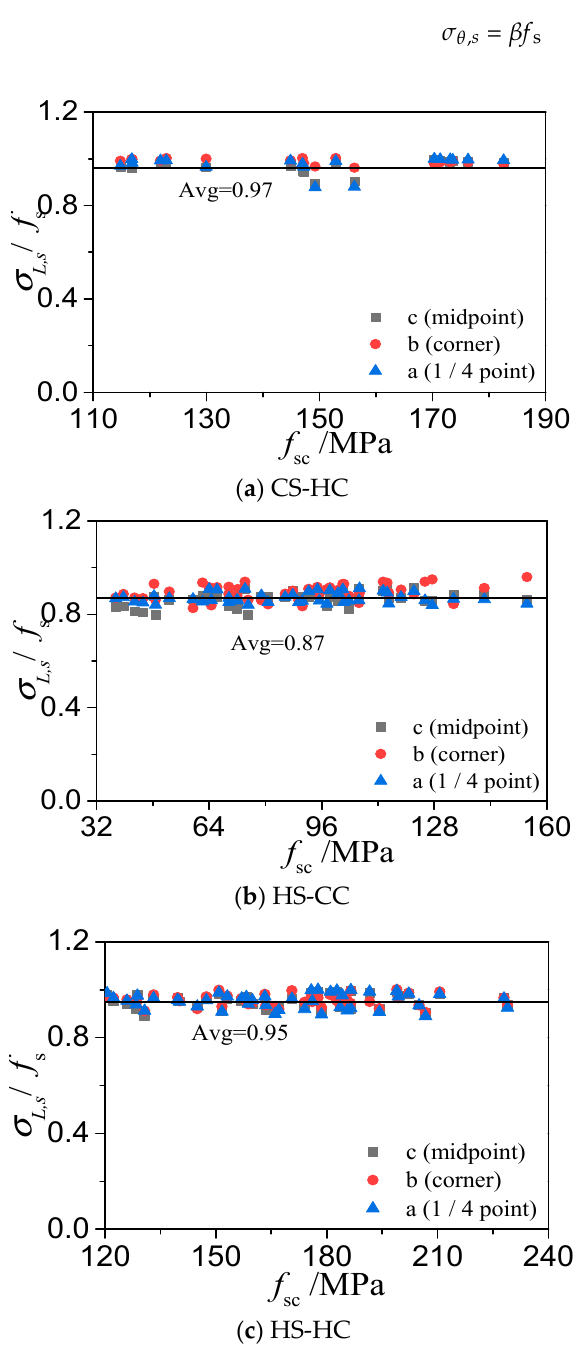
Figure 11. Average ratio of longitudinal stress to yield strength of a high-strength steel tube.